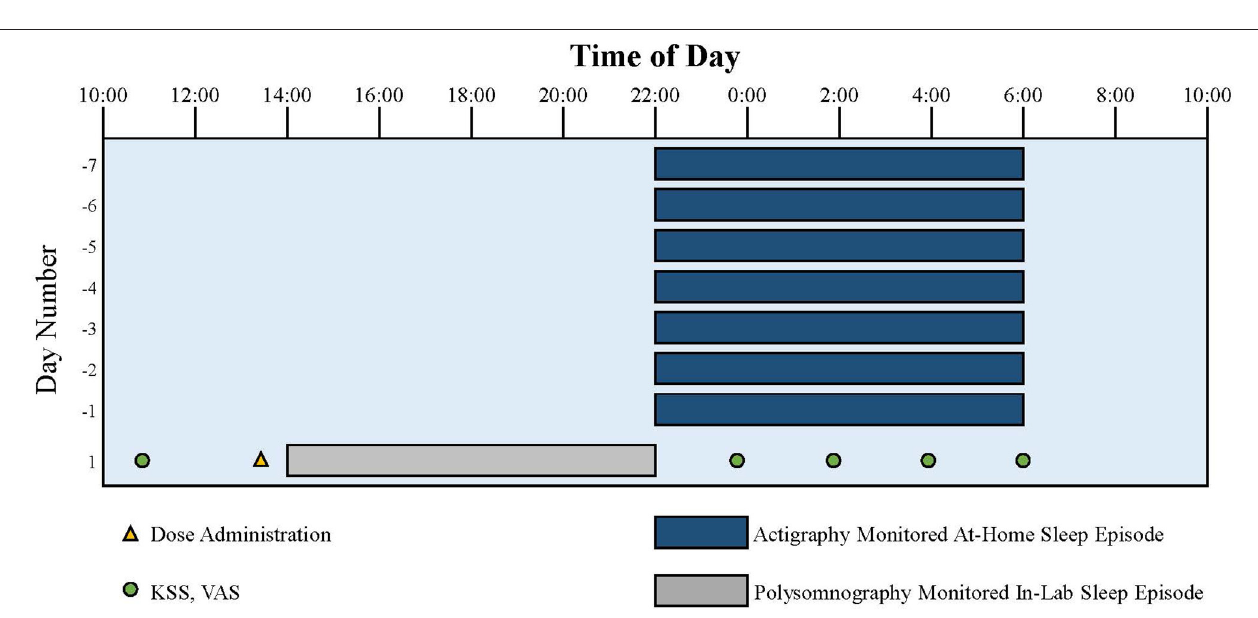
FIGURE 2 | Representation of the study protocol for an individual with a usual target bedtime of 22:00. Dark blue bars indicate at-home sleep monitored with actigraphy and photometry. Gray bar indicates in-lab sleep monitored with polysomnography following the 8-hour phase advance imposed to model the change of sleep timing required after a trip from Los Angeles to London. Yellow triangle indicates dose administration. Green circles indicate KSS and VAS